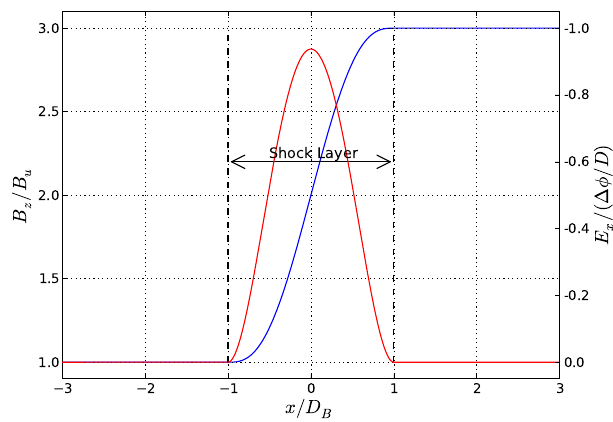
Fig. 1. Profiles for the electric, E x (red curve), and magnetic, B z (blue curve), fields in dimensionless units (see Eq. (5) - (7)). The shock width is set by the parameter D B with the D B = D E = 1 case illustrated in the figure. Note that the E x scale is negative.